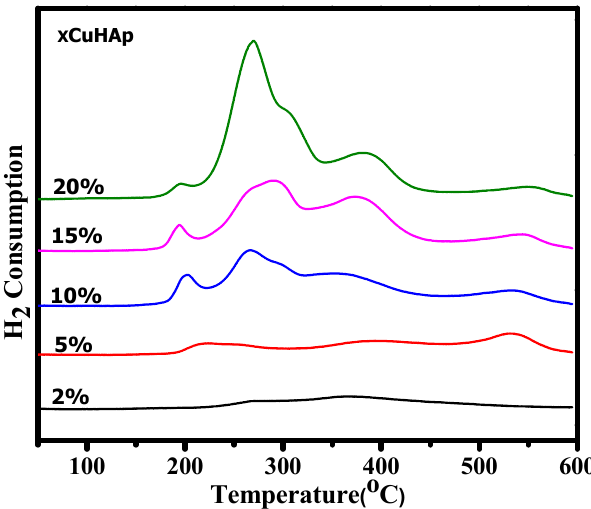
Figure 4. TPR profiles of CuHAp catalysts with various Cu loadings.